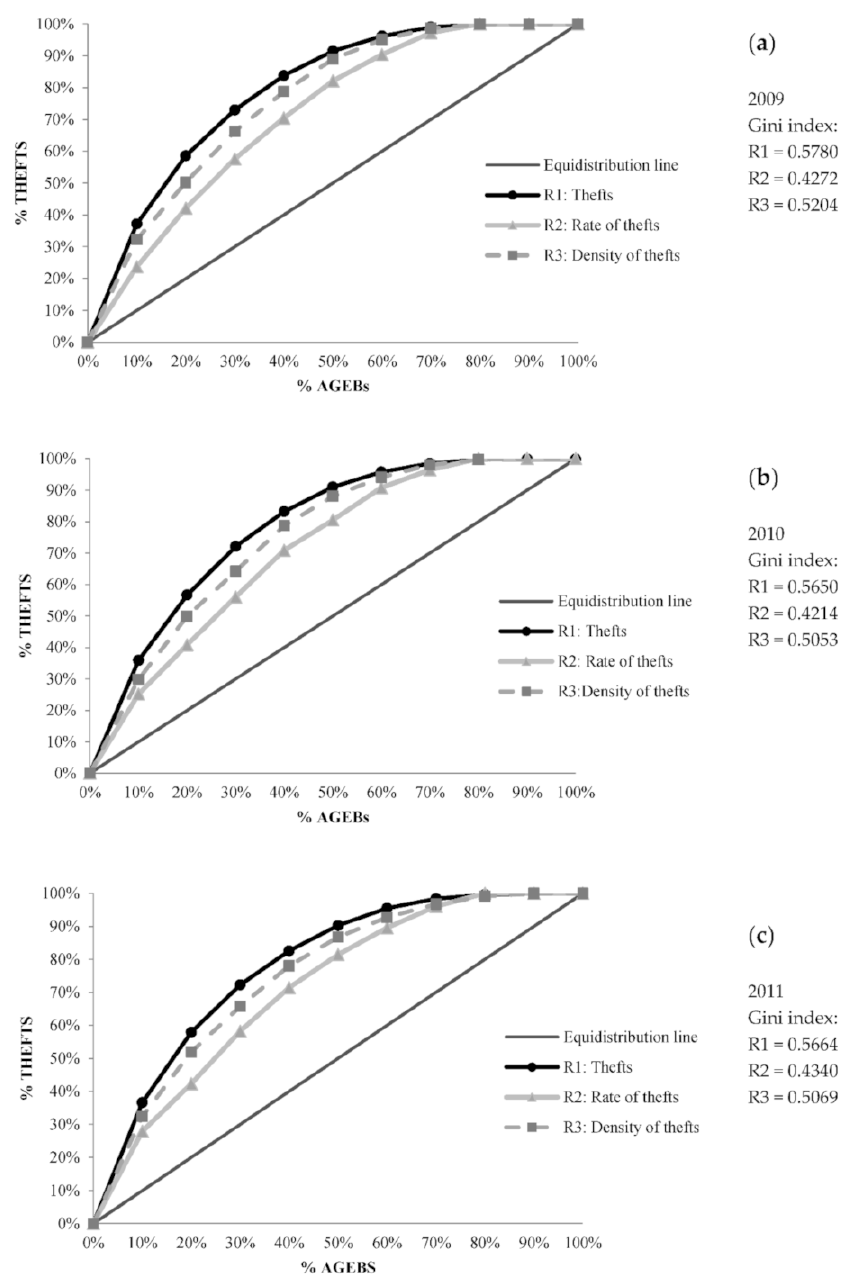
Figure 3. Lorenz curves and Gini coefficient per decile from 2009 to 2011. ( a ) Lorenz curve 2009 ( b ) Lorenz curve 2010, ( c ) Lorenz curve